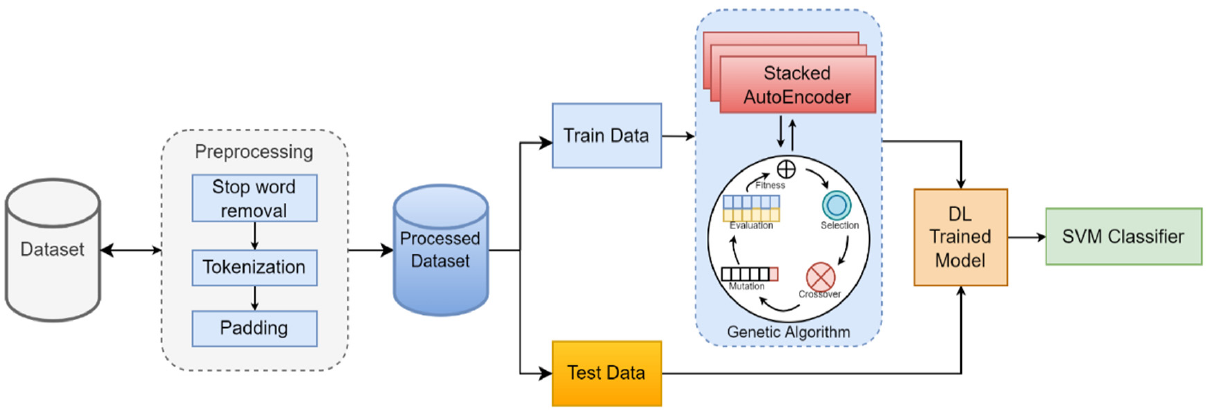
Figure 3. Diagram of the proposed hybrid model.